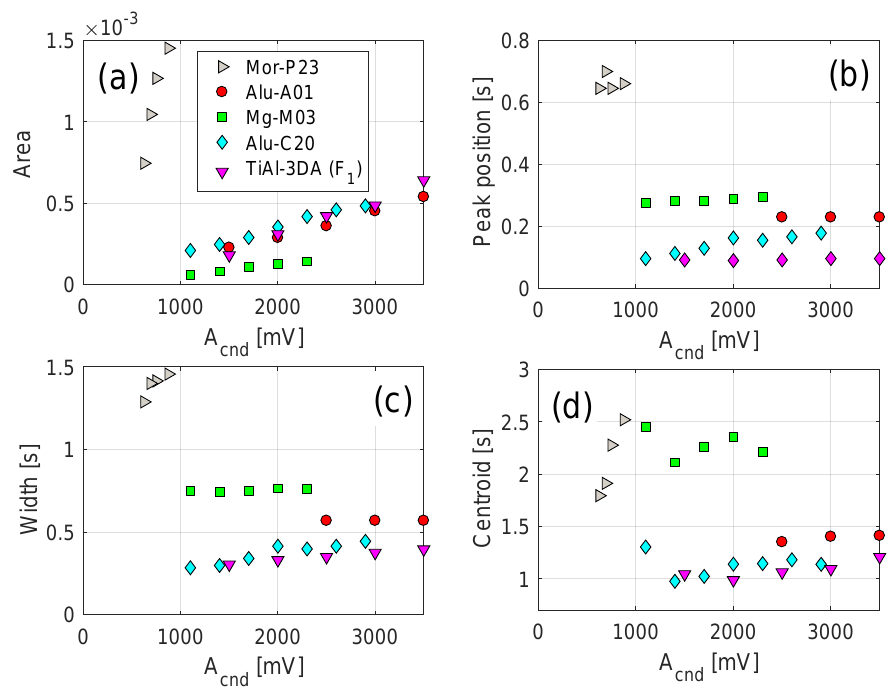
Figure 8. Properties of the relaxation times distribution for the tested samples as a function of conditioning amplitude. ( a ) Area; ( b ) Peak position; ( c ) Width; ( d )